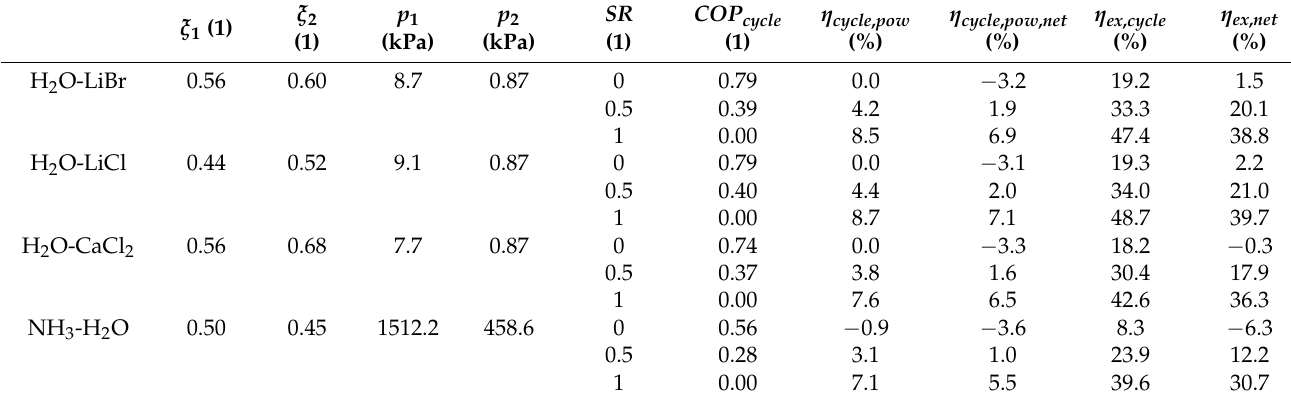
Table 3. Main resulting cycle parameters of the different working fluids: salt solutions and water–ammonia mixture. ξ 1 (1)